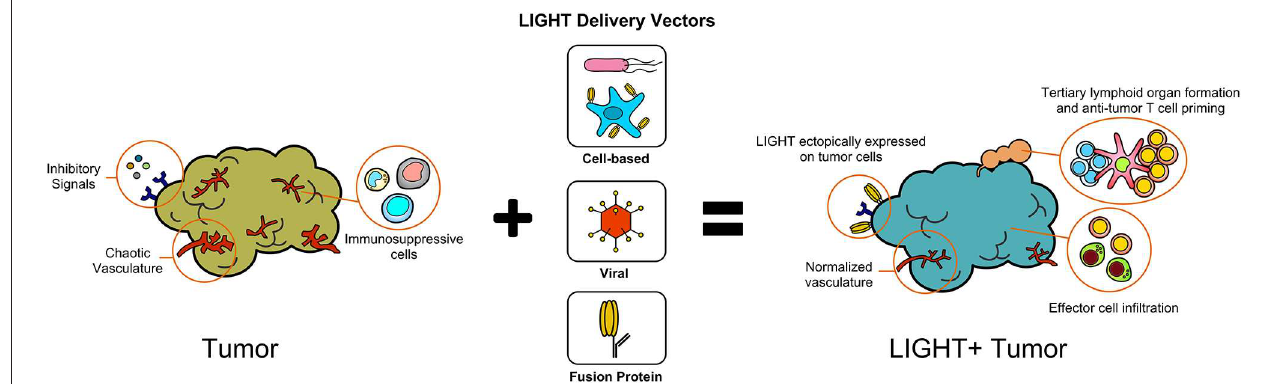
FIGURE 1 | Delivery of LIGHT through different methods modifies the tumor